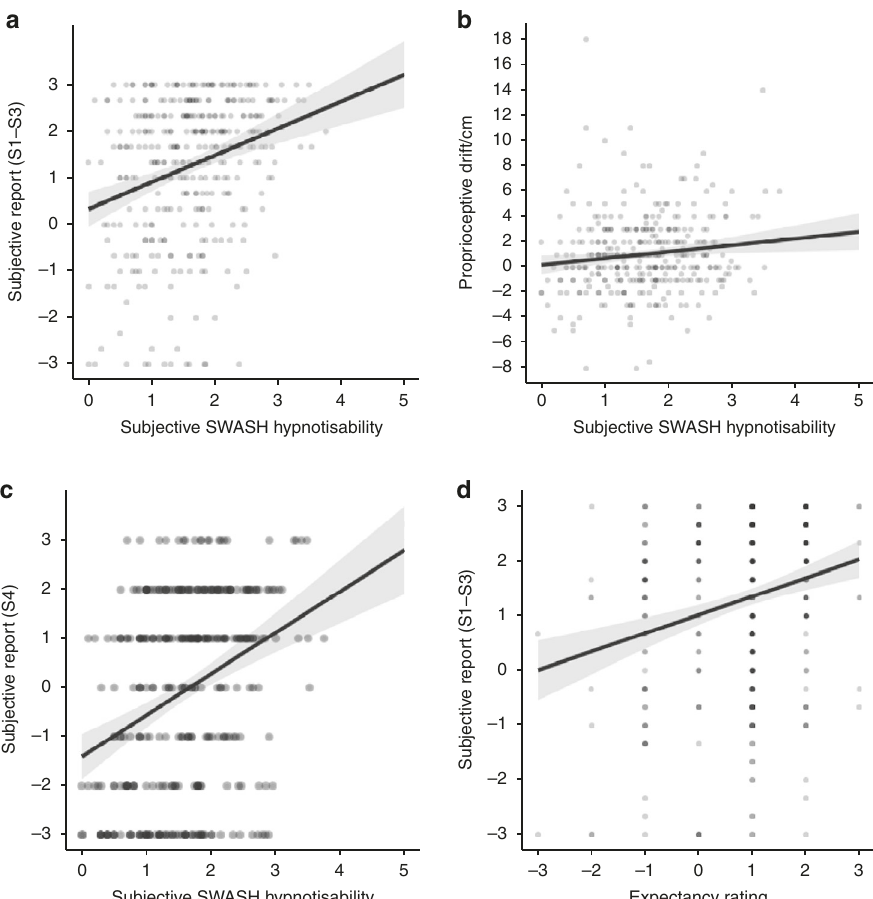
Fig. 3 Scatter plots showing linear regression ( n = 353 participants) of synchronous condition rubber hand illusion measures on hypnotisability and expectancies. a Mean subjective report for location and ownership (S1 – S3) on hypnotisability, r s = 0.26, 95% CI [0.16, 0.37]. b Proprioceptive drift on hypnotisability, r s = 0.11, 95% CI [0.003, 0.22], ( c ) subjective report for visual hallucination (S4) on hypnotisability, r s = 0.31, 95% CI [0.21, 0.43], and ( d ) synchronous condition mean subjective report for location and ownership (S1 – S3) on synchronous condition expectancy. r s = 0.23, 95% CI [0.13, 0.34]. Error bars show 95% CI. The centre of credibility intervals is the predicted score. Note: SWASH is an abbreviation of Sussex-Waterloo Scale of